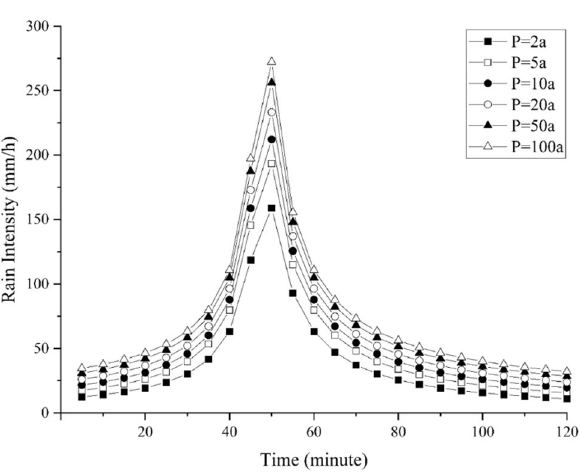
Figure 4. Two-hour rainfall process of adopted return periods. This graph was generated with OriginPro 2021 (Learning Edition)(https:// www. origi nlab. com/).